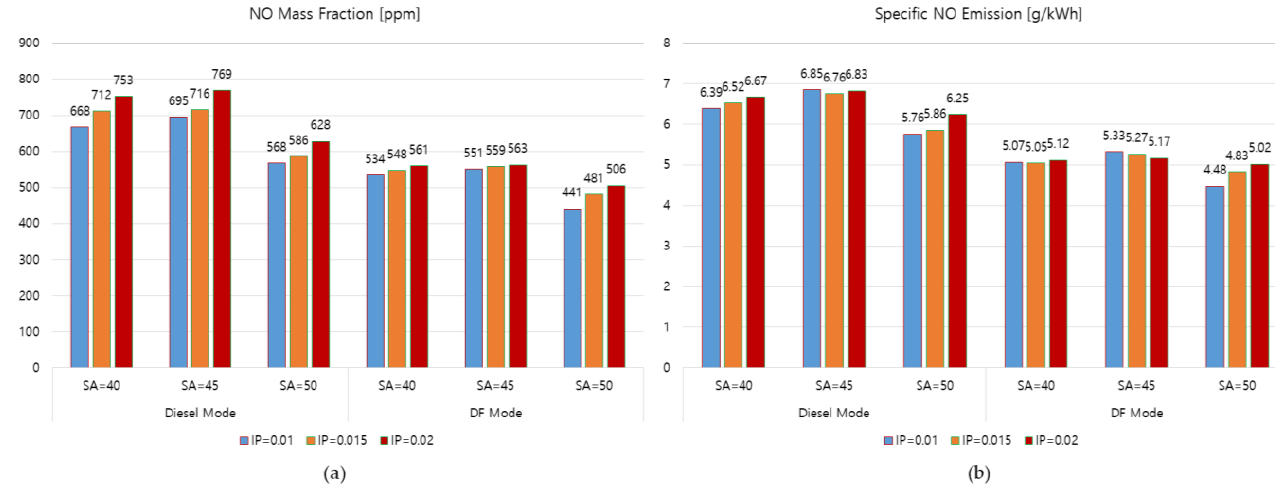
Figure 14. NO emissions in all simulation cases: ( a ) NO mass fraction, ( b ) specific NO emissions.